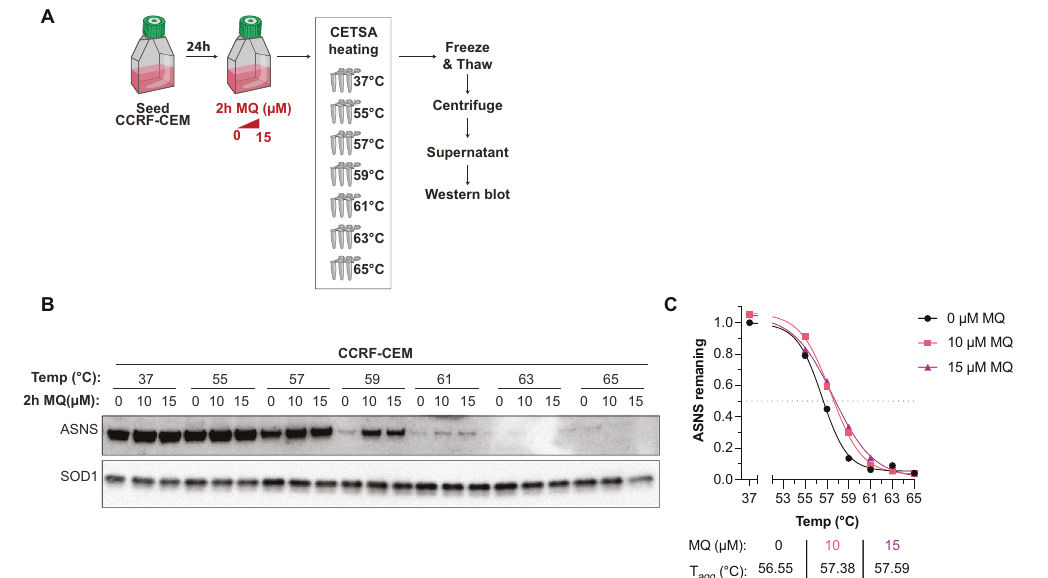
Fig. 2 MQ thermostabilizes ASNS in ALL cells. A Overview of experimental set-up for MQ treatment of CCRF-CEM cells and WB-CETSA 2h after treatment. B WB-CETSA of CCRF-CEM cells treated for 2 h with the indicated concentrations of MQ and heated at the indicated temperature as shown in A . SOD1 was used as is a thermally stable loading control. n = 1. C Quanti fi cation of WB-CETSA in B . ASNS signal was normalized to loading control SOD1 in the same samples. All values were normalized to 37 °C without MQ. Aggregation temperature ( T agg ) was determined at 50% remaining ASNS according to the Boltzmann sigmoidal curve. n = observed at later time points (Fig. S1D), as also shown by cell con fl uency (Fig. 1C) and caspase-3 cleavage (Fig. S1E). MQ was (Fig. S1E) as expected, since conversion of APR-246 to MQ takes certain time. Taken together, these data demonstrate that the